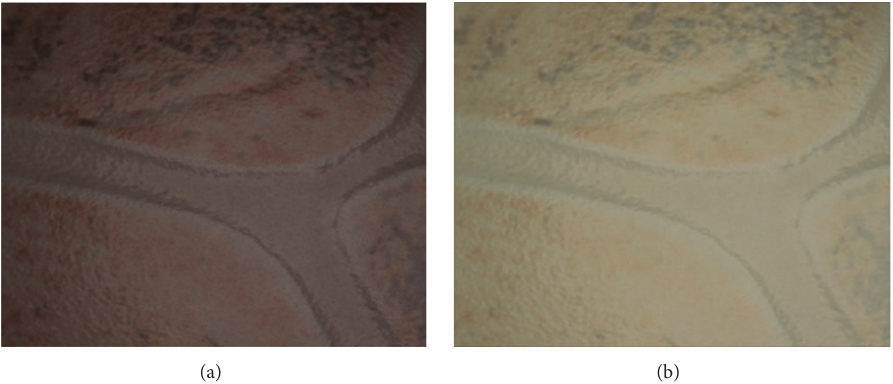
Figure 11: The images captured by a linear polarizer before and after calibration. (a) Before calibration and (b) after calibration.